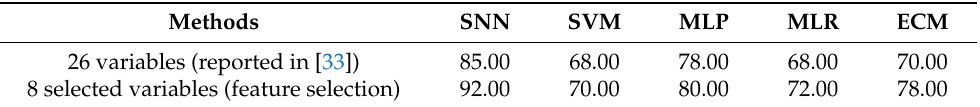
Table 2. The classification accuracy between EEG samples in control and OP obtained when using all EEG variables versus using the eight top-informative variables selected with the use of the proposed dynamic spatiotemporal clustering method.